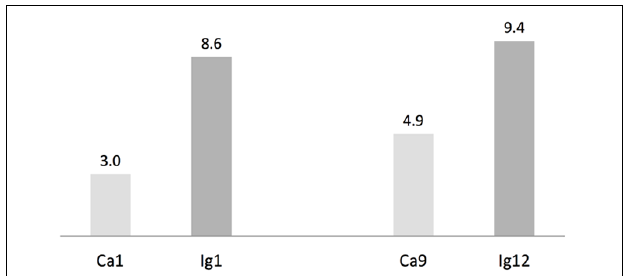
FIGURE 5 | Number of non-ribosomal peptides (NRP) synthetases and polyketides (PK) synthases genes per Mbp in cyanobacteria draft genomes from the calcite (Ca1 and Ca9) and ignimbrite (Ig1 and Ig12) communities using AntiSmash